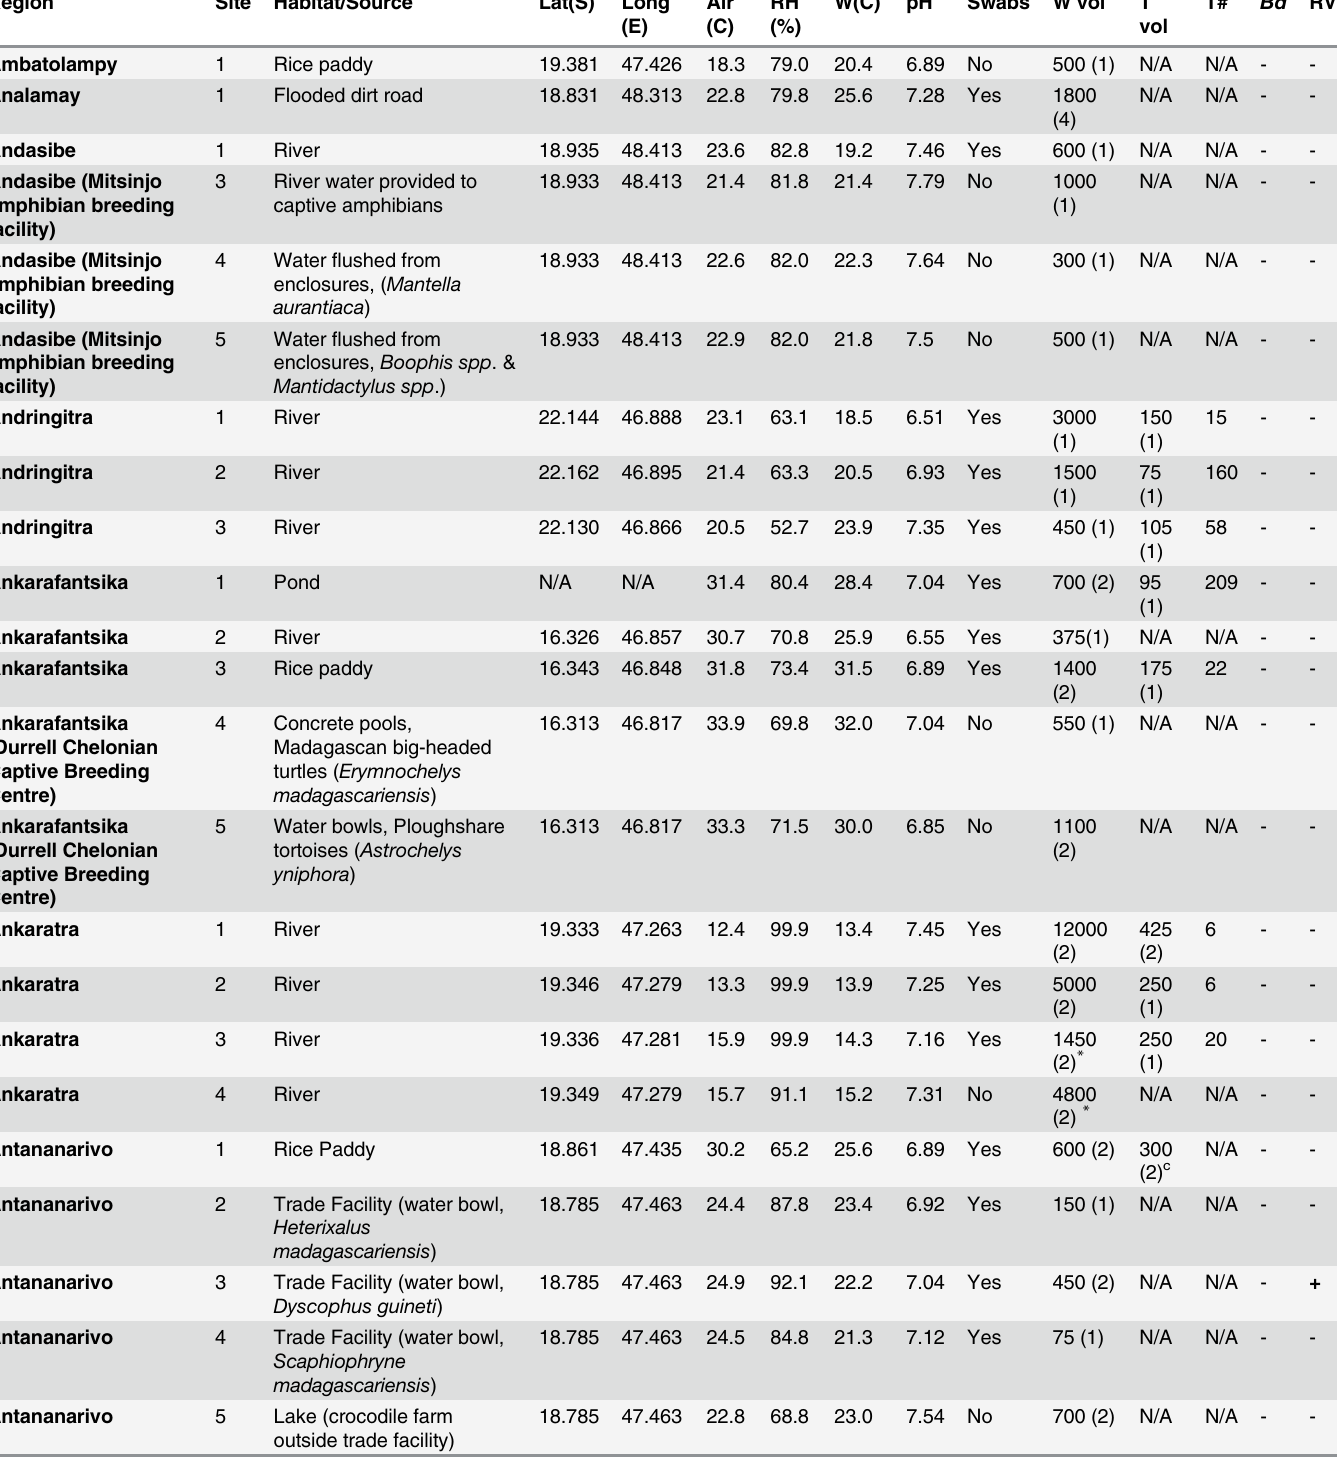
Table 4. Water filter samples processed by quantitative PCR for detection of Batrachochytrium dendrobatidis ( Bd ) and ranavirus (RV) in Madagascar.